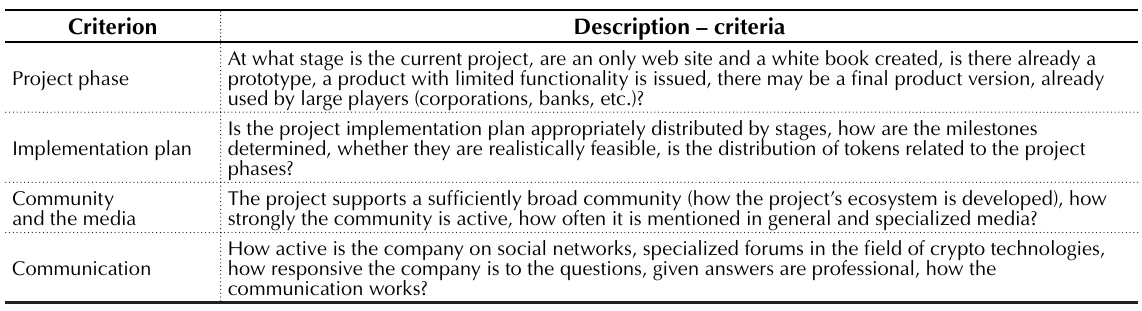
Table 3. Dimension “The project implementation”